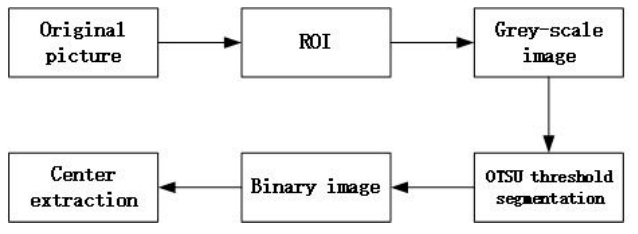
Figure 6. Flow chart of center extraction of registration markers. Table 8. Boundary point I extraction from di ff erent pixel images.